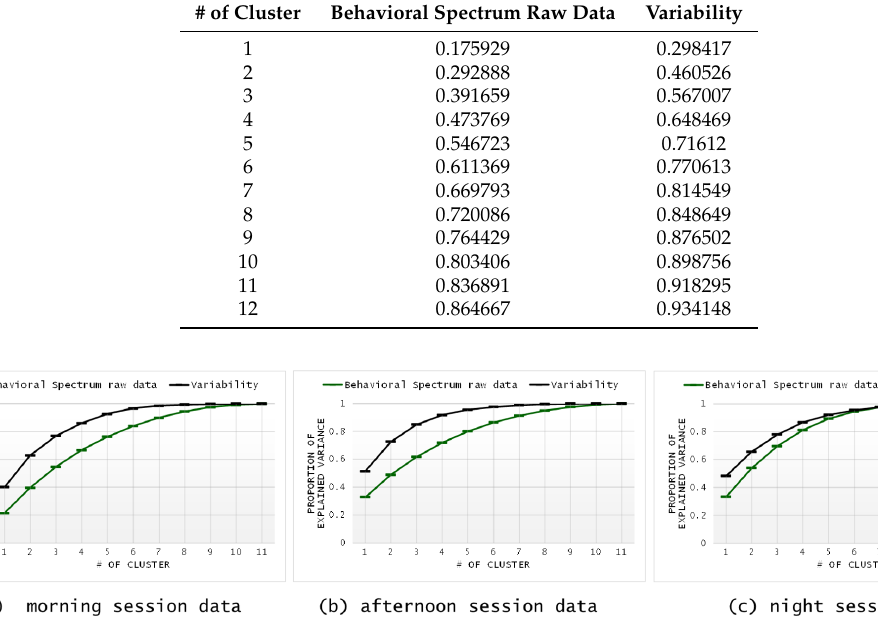
Figure 10. Proportion of explained variance in the data of behavioral spectrum raw data/variability by the number of clusters for the HISUISUI care home